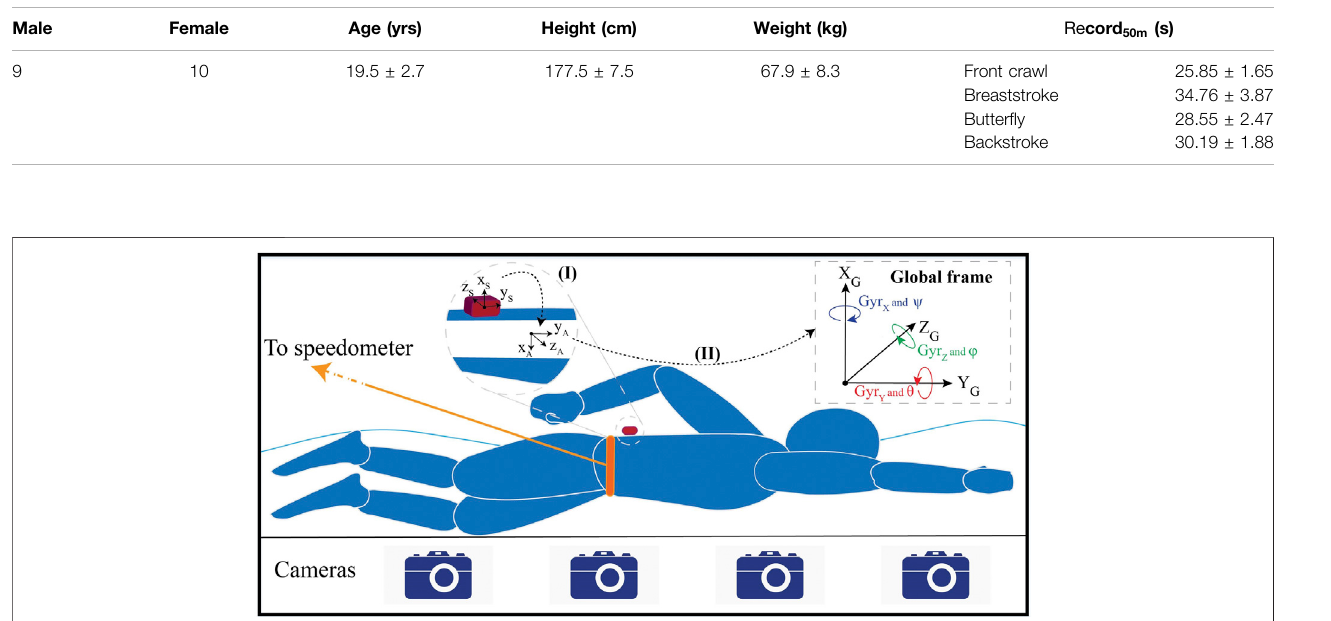
FIGURE1| MeasurementsetupincludingoneIMUattachedtothesacrum,fourcamerastocapturethewholelapandtetheredspeedometertorecordswimmer ’ s displacement and velocity.IMU data istransferredfrom sensorframe (x,y,z) S , fi rst toanatomicalframe (x,y,z) A using functional calibration(I),and then tothe global frame (X,Y,Z) G using the gradient-descend based optimization algorithm (II). The global axes of acceleration, angular velocity and angles are displayed in the fi gure.